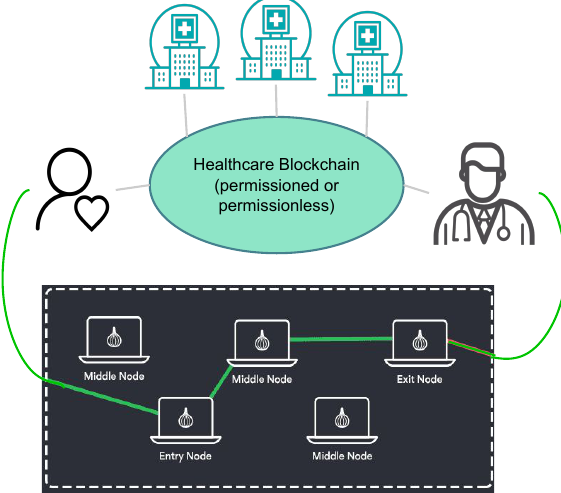
Figure 1. The proposed blockchain-based remote health monitoring (RHM)